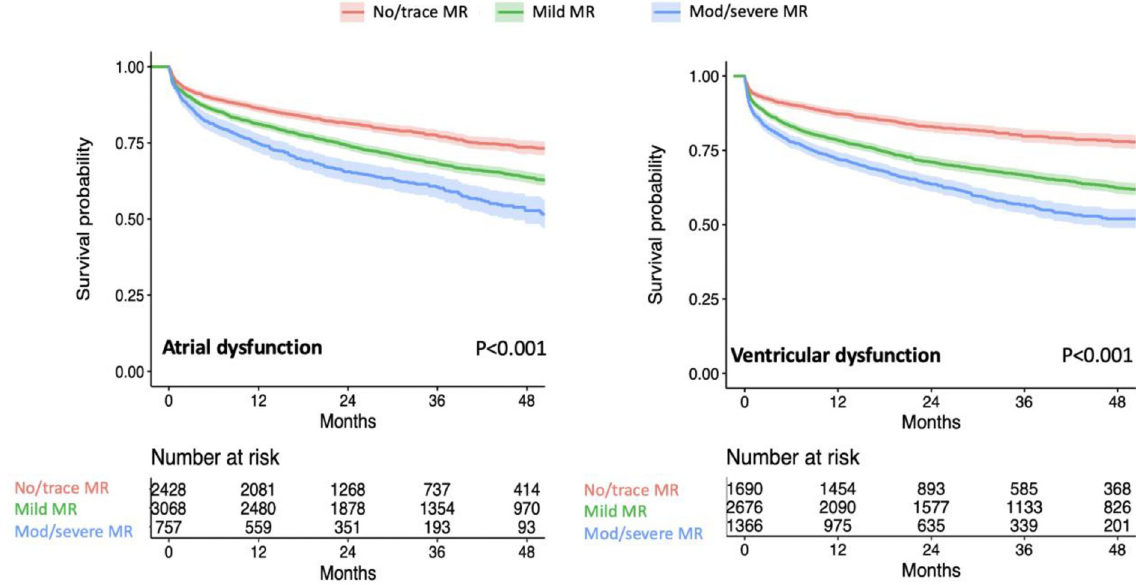
Fig 2. Unadjusted survival curves by different severities of mitral regurgitation. The figure shows Kaplan-Meier curves of patients with no or trace mitral regurgitation (MR) (red), mild MR (green), and moderate or severe MR (blue), stratified by patients with atrial dysfunction (left) and patients with ventricular dysfunction